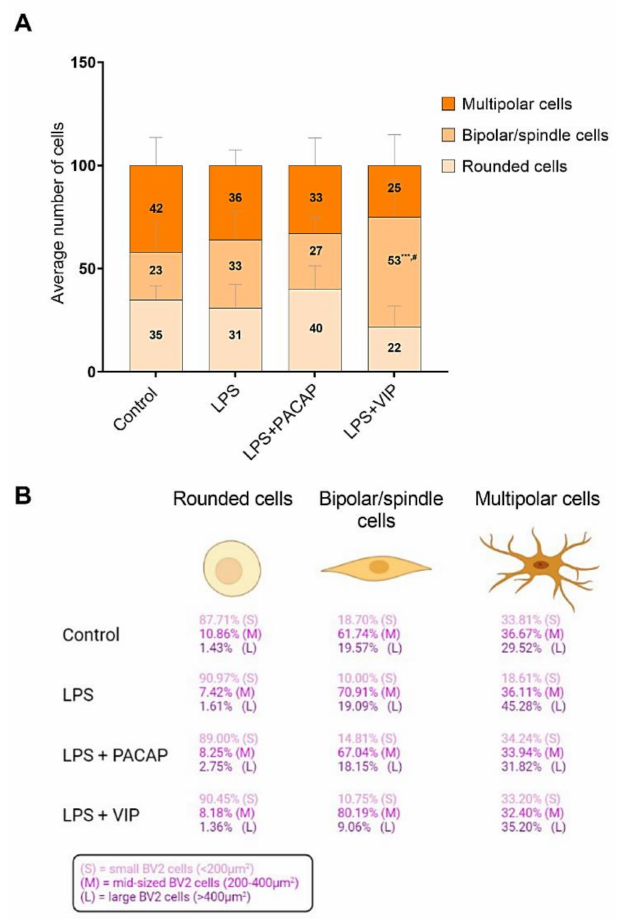
Figure 9. Redistribution of BV2 microglial cell subpopulations based on morphology after treatment with LPS only, LPS + PACAP and LPS+VIP. BV2 cells plated at 5 × 10 5 in 25 cm 2 flasks were starved with 1% FGM for 24 h prior to treatment with 10% FGM (control), LPS (1.0 µ g/mL), LPS + PACAP (100 nM) and LPS + VIP (100 nM) for 24 h. Images were captured using Nikon Eclipse Ts2 inverted microscope. ( A ) Average number of cells presenting with either rounded, bipolar/spindle or multi- polar shape in each experimental condition. ( B ) Percentage of BV2 cells for each morphology that exhibited either a small (S), mid-sized (M) or large soma (L). Investigators conducting stereological and morphometric measurements were blind to the experimental conditions. Measurements and cell counts were performed using Image J 1.51 (NIH) software. An average of 100 cells per experimental condition were analysed, with each condition replicated using ten different batches of cells ( n = 10). *** p < 0.001 vs. control or # p < 0.05 vs. LPS-treated cells, as determined by two-way RM ANOVA followed by Tukey post hoc